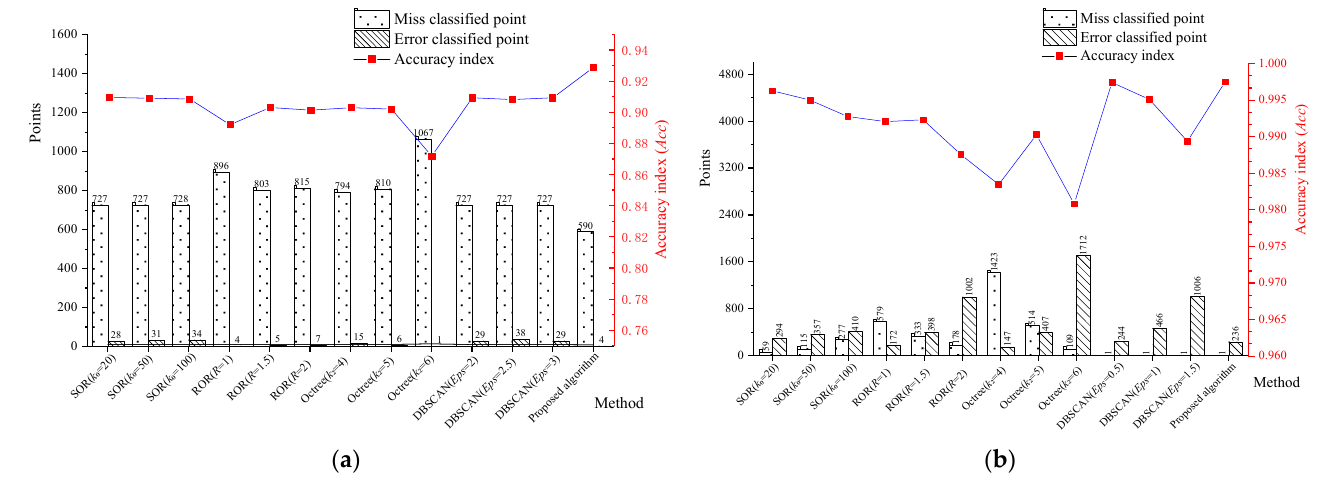
Figure 8. Large-scale noise filtering results. a ) are Airplane point cloud; ( b ) are Building point cloud.